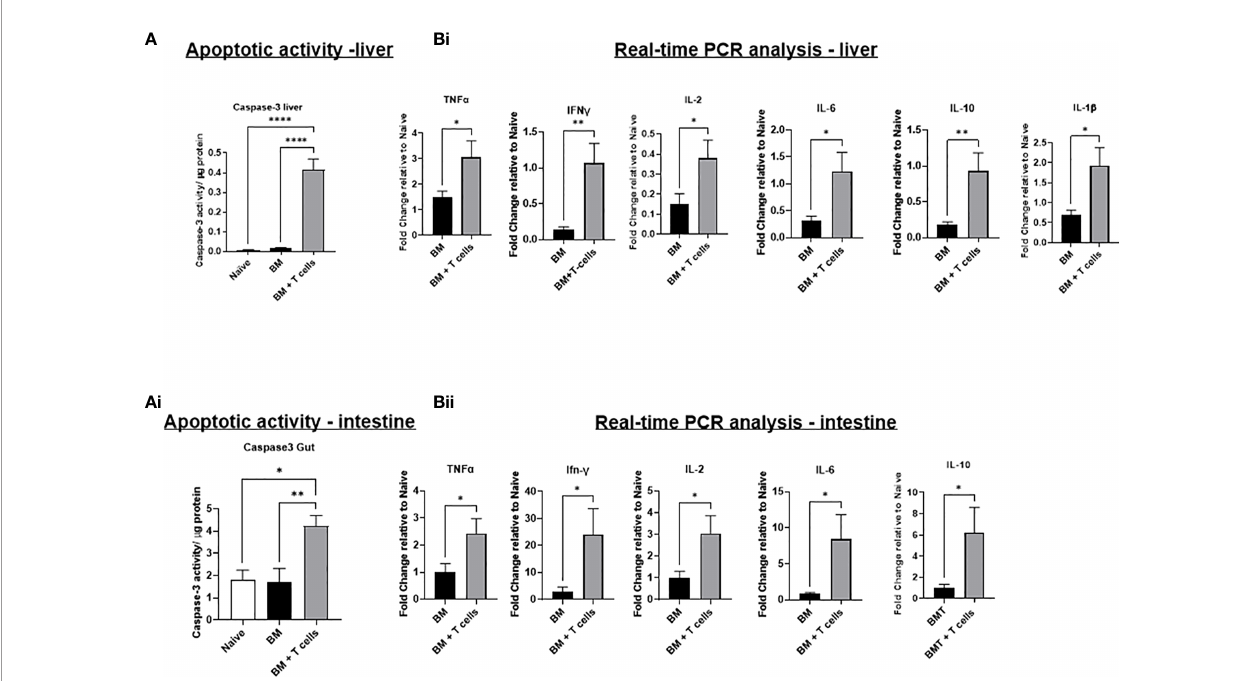
FIGURE 2 | Signi fi cant increases in apoptotic activity and in gene expression of in fl ammatory cytokines suggests the onset and progression GvHD in mice transplanted with BM+T-cells – (A) Signi fi cant increase in caspase-3 activity in the (i) liver and (ii) intestine of mice transplanted with BM+T-cells compared to mice transplanted with BM only. A fl uorescence-based caspase 3 activity assay was used to determine apoptotic activity in liver and intestine lysates. Data is Mean ± SEM. n=5-7. *p < 0.05, **p < 0.005, ****p < 0.00005. One-way ANOVA with Tukey multiple comparison Test. (B) Quantitative real time PCR analysis showing signi fi cant increases in gene expression of in fl ammatory cytokines in (i) liver and (ii) intestine samples of mice transplanted with BM+T-cells compared to BM only. Data is Mean± SEM. n=5-7. *p < 0.05. Unpaired t test.